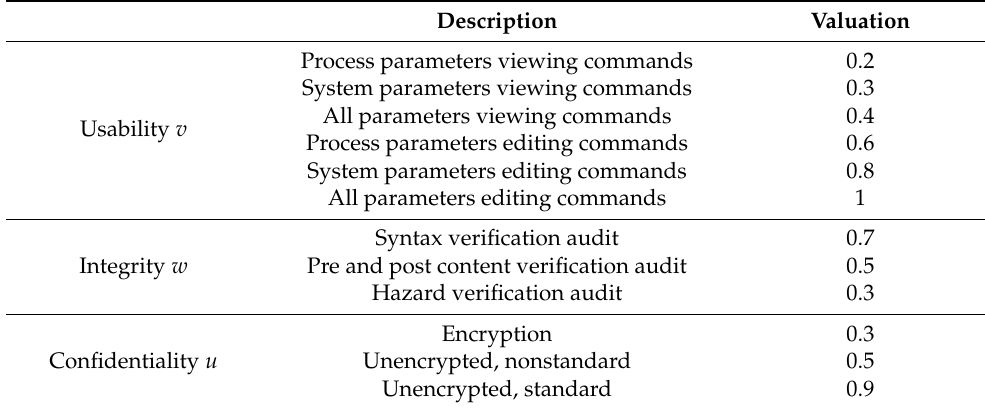
Table 3. Data weakness valuation